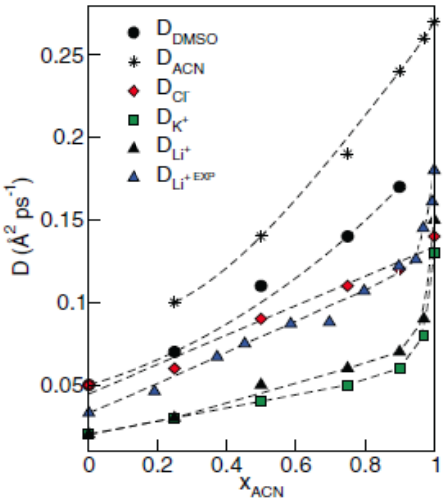
Figure 40. Diffusion coefficients for different species. DMSO: circles, ACN: stars, Cl − : red diamonds, K + : green squares, Li + : black triangles. Also shown are experimental results for Li + (blue triangles) obtained from conductivity measurements [69]. Reprinted from Laria at al. [70] with the permission of AIP Publishing.